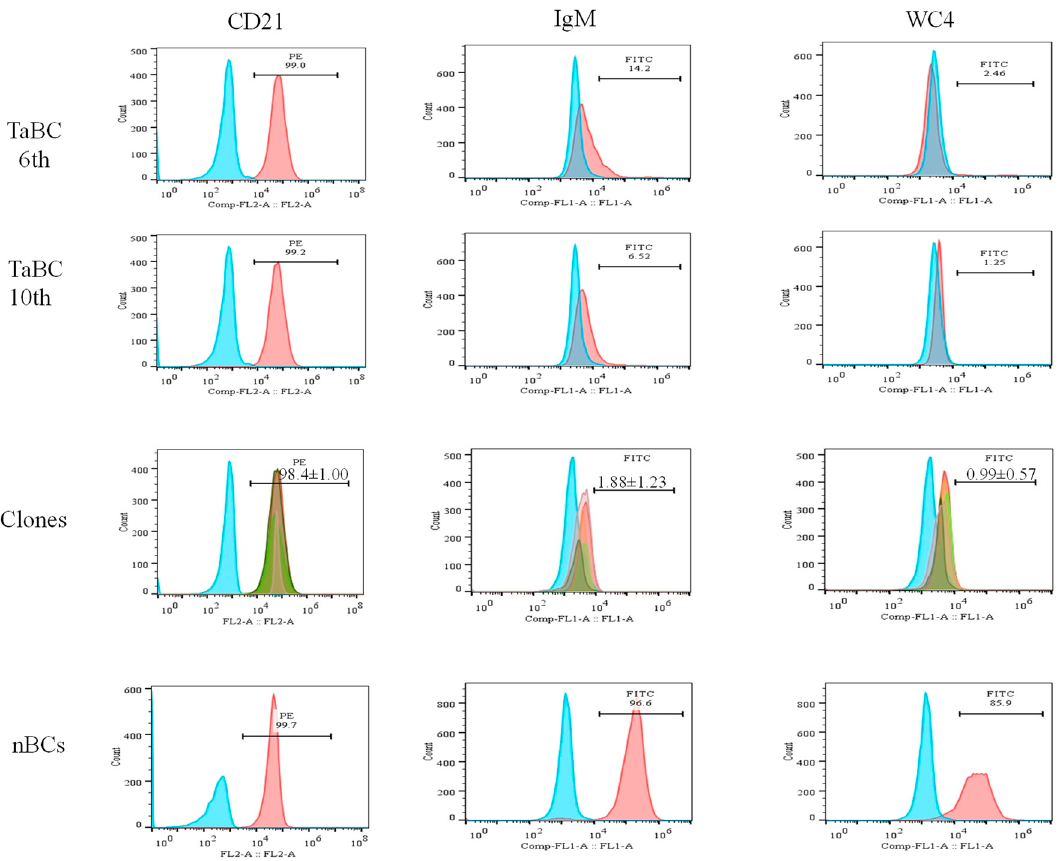
Figure 6. Percentages of B cell-specific surface markers (CD21, IgM, and WC4) present in transformed cells (6th and 10th generations), single-cell line clones (approximately 15th generation), and normal purified cells. The percentages of CD21 (98.8, 99.7, 98.0, 98.5, and 97%; mean ± SD of 98.4 ± 1.00), IgM (3.51, 0.64, 1.42, 0.99, and 2.83%; mean ± SD of 1.88 ± 1.23) and WC4 (0.51, 1.96, 0.71, 0.80, and 0.97%; mean ± SD of 0.99 ± 0.57) in five clones were determined. CD21 was present in mono- and polyclonal cell lines, while negligible percentage of IgM and WC4 were present.